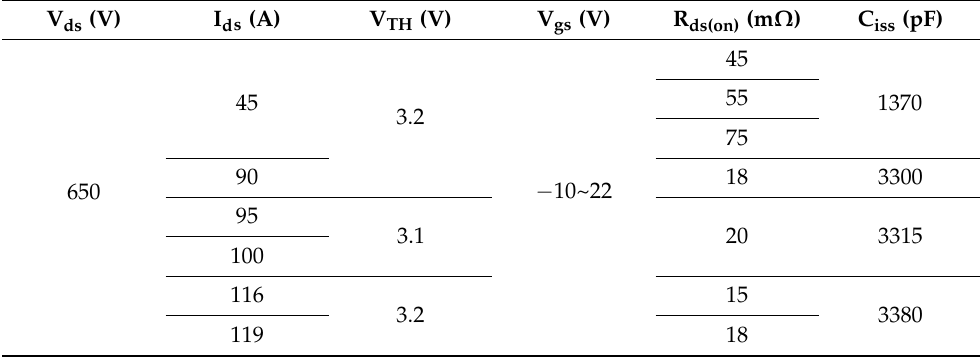
Table 9. Commercial 600~1200 V SiC MOSFETs by